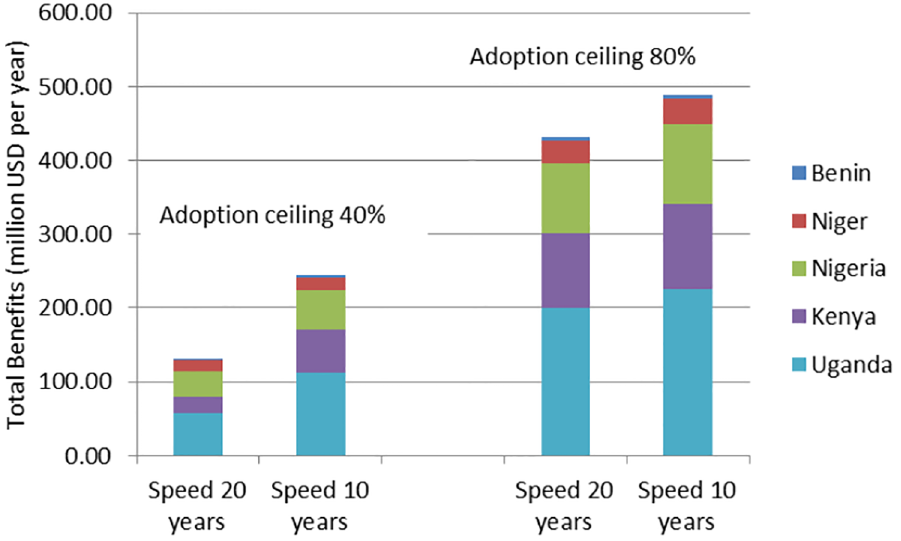
Fig 3. Comparison of doubling the speed of adoption and the ceiling of adoption. Note. Parameter values: discountrate r = 0.04; d = 0.5; elasticity of supply ε = 0 . 6 , elasticity of demand η = -0 . 3 . See Table C in S1 Table for different